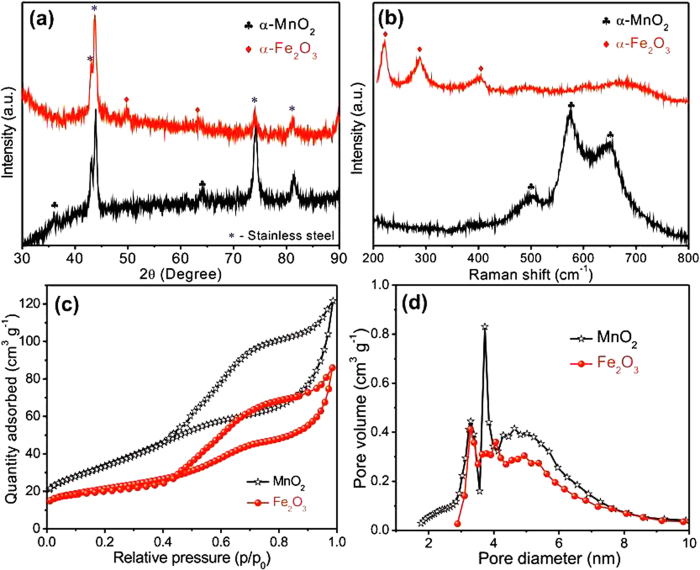
(a) XRD patterns (b) Raman spectra of MnO2 and Fe2O3 electrodes. (c) Nitrogen adsorption-desorption isotherms and (d) pore size distribution curves of powder MnO2 and Fe2O3 samples.